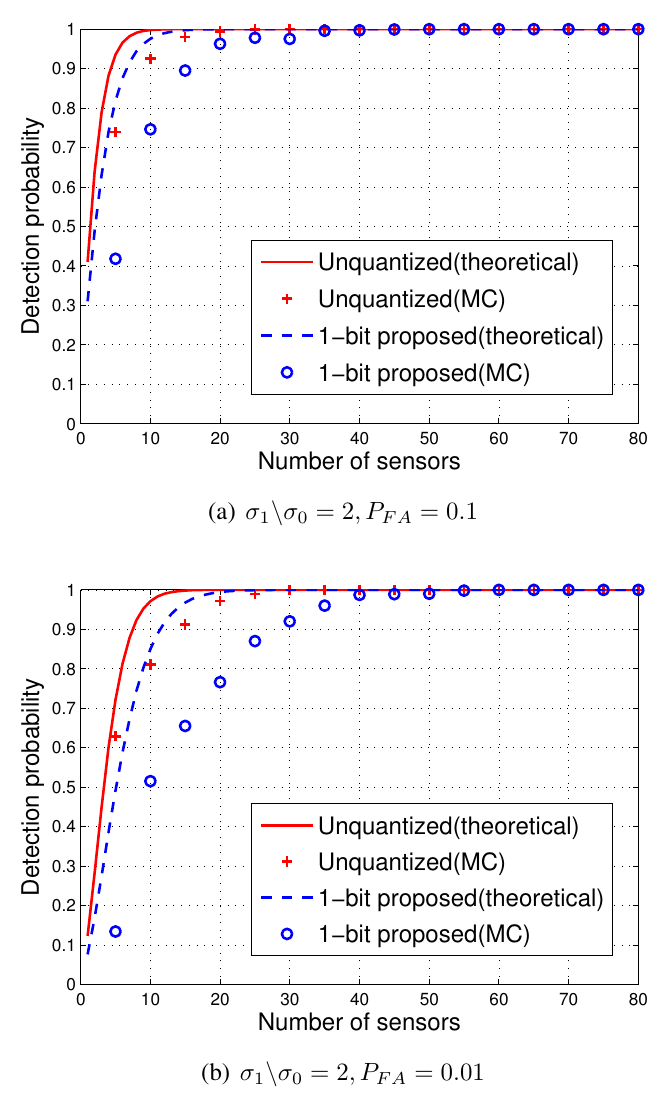
Figure 2. Performance the proposed one-bit generalized likelihood ratio test (GLRT) detector with the optimum threshold τ (cid:63) and the unquantized detector, when P and 0 . 01 ( b